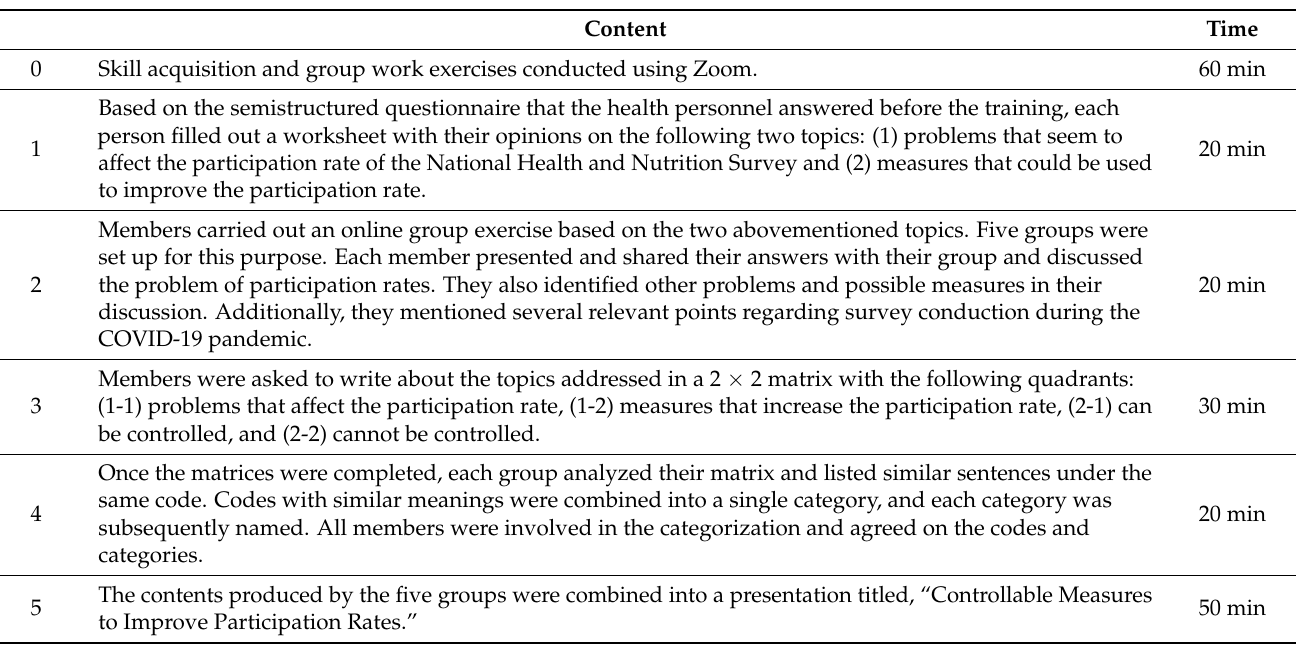
Table 1. Workshop